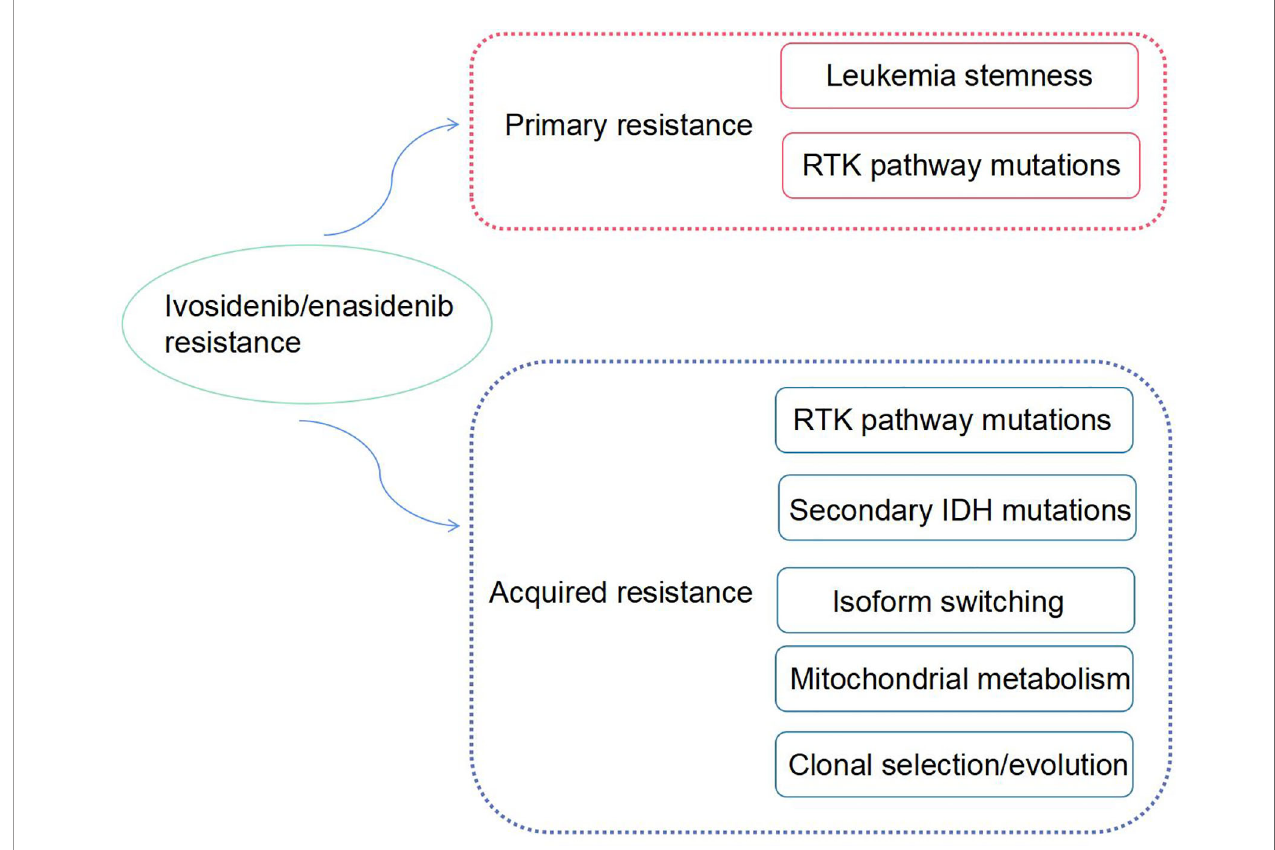
FIGURE 1 | The mechanisms of ivosidenib/enasidenib resistance in